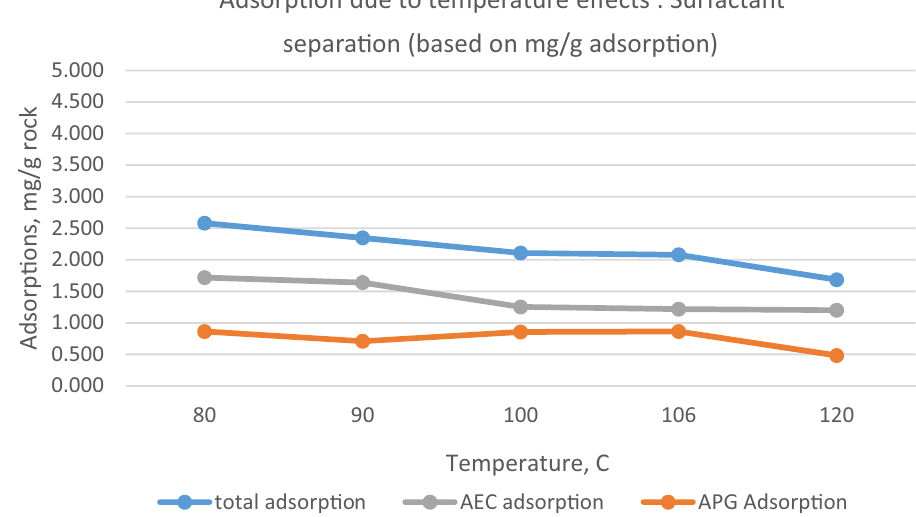
Adsorp(cid:15)on due to temperature effects : Surfactant separa(cid:15)on (based on mg/g